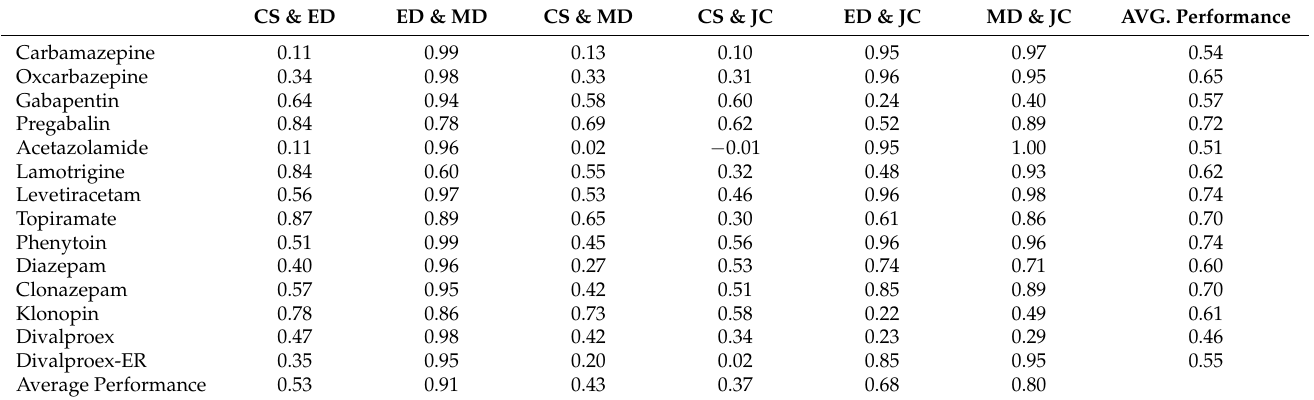
Table 12. AEDs Drug-Drug Similarities from DrugSimDB.